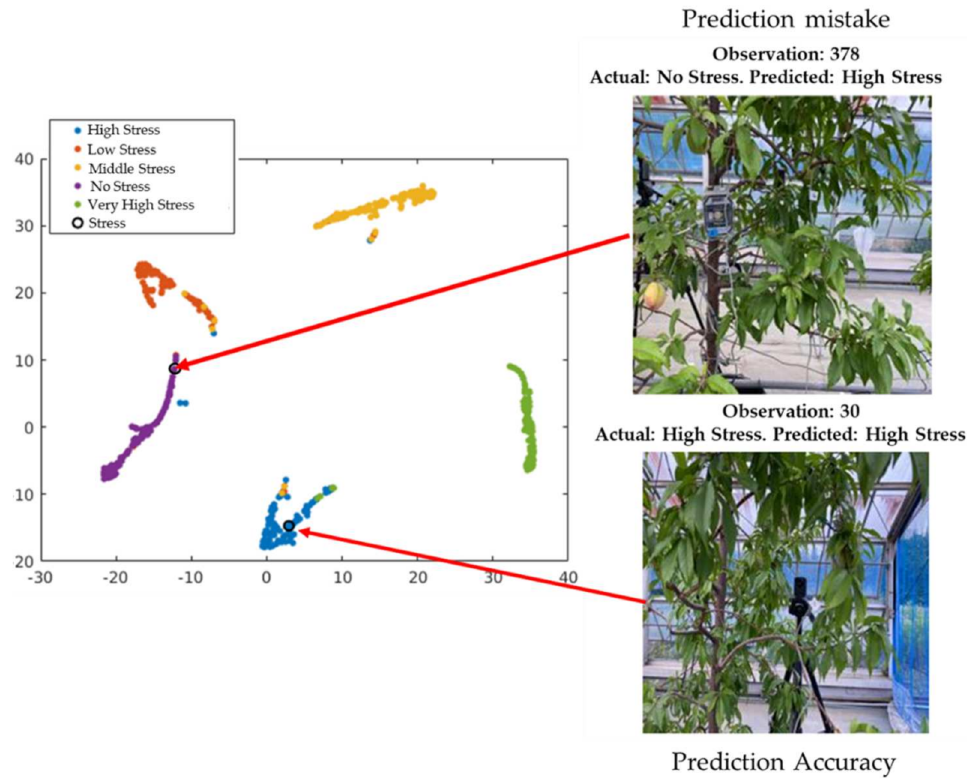
Figure 13. Exploration of observations in the t-SNE plot based on test